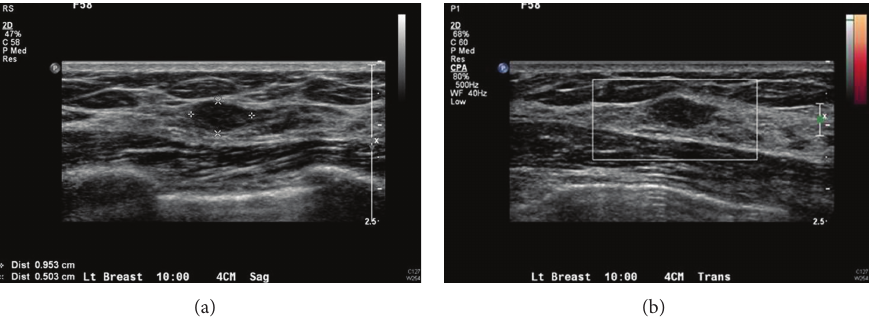
Figure 2: (a) Ultrasound evaluation in the upper inner breast demonstrates an oval, hypoechoic lesion, corresponding to the lesion seen on MRI (though slightly larger in dimension) with minimally irregular margins. (b) No increased vascularity.